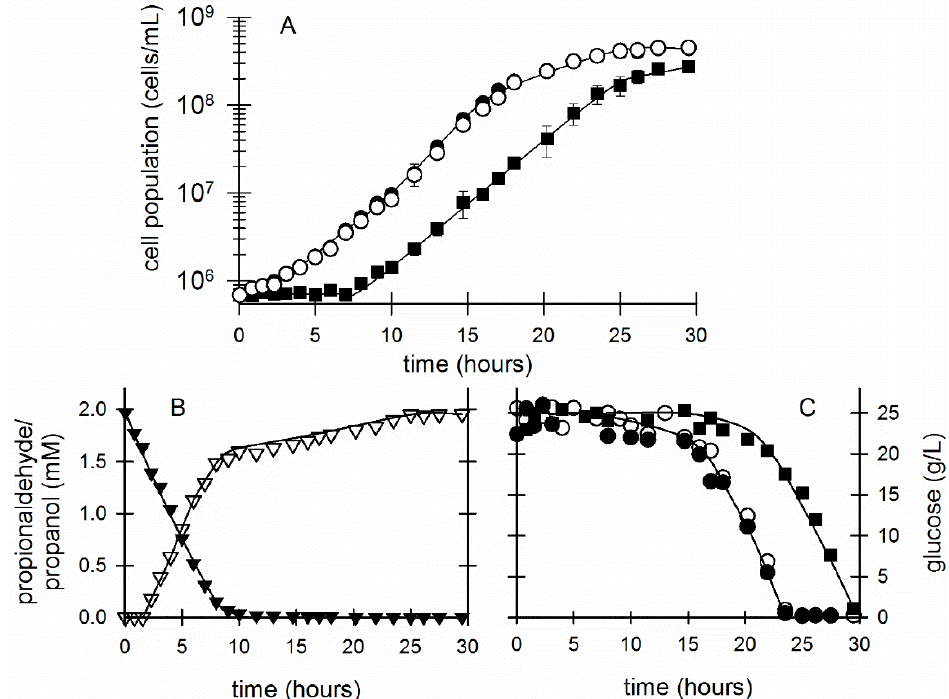
Figure 1. Effect of acetaldehyde supplementation on the growth of Z. mobilis in medium containing 50 g/L ethanol.  ,  ethanol-stressed culture without acetaldehyde addition;  ,  ethanol-stressed culture supplemented with 2 mM (90 mg/L) acetaldehyde;  ,  control culture (without ethanol stress). ( A ) Cell population (closed symbols); ( B ) acetaldehyde concentration (open symbols).